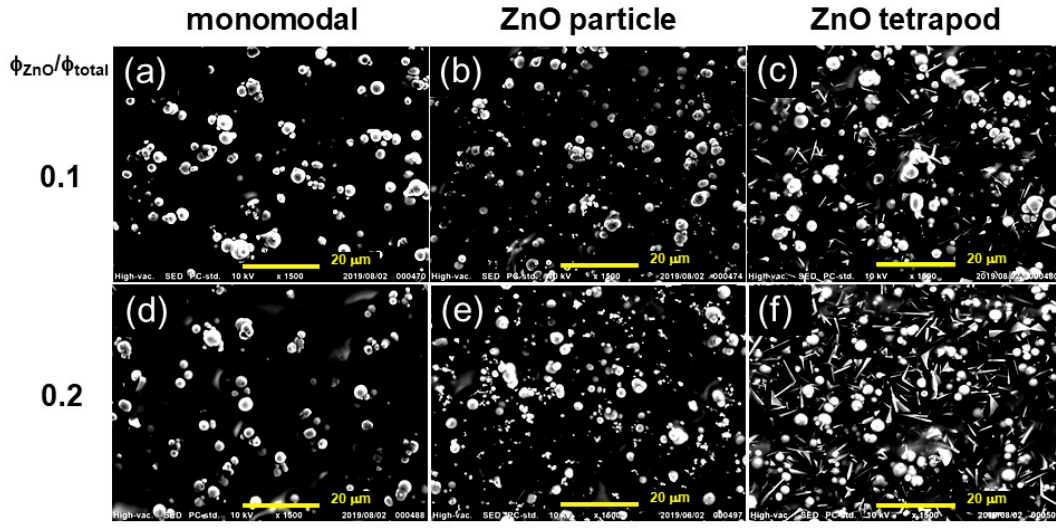
Figure 5. Change in storage modulus for bimodal magnetic elastomers containing nonmagnetic particles or tetrapods as a function of the substitution ratio. The change in storage modulus for monomodal magnetic elastomers with the same volume fraction of magnetic particles as bimodal magnetic elastomers, is also shown (Frequency 1 Hz, Strain 10 − 4 ).